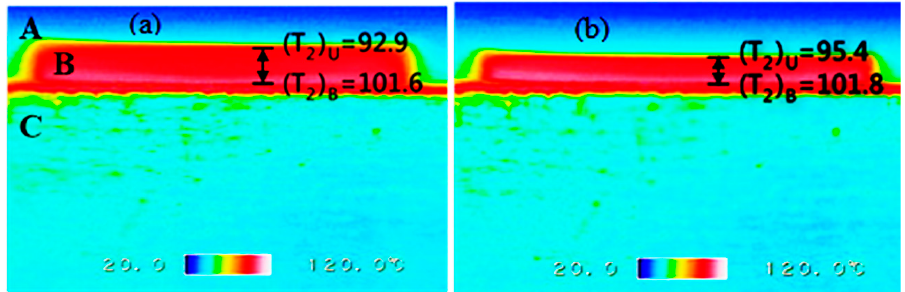
Figure 3. Temperature distribution of the indium tin oxide (ITO) thin film coated on the ( a ) N-BK7; ( b ) S-TIM35 glass substrates.